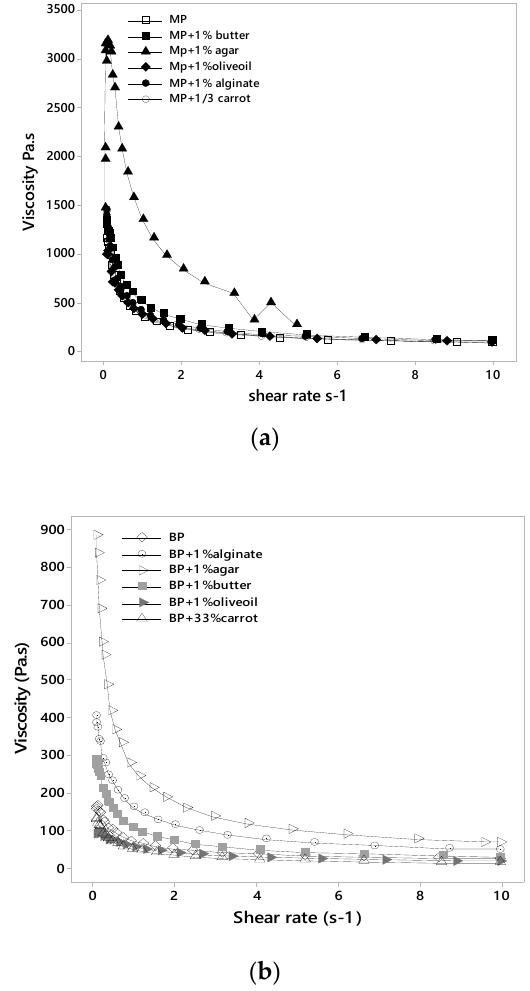
Figure 2. Typical flow curve of potato tubers with different substrates ( a ) microwaved and ( b ) boiled. Inset: flow curves at a shear rate below s − 1 .